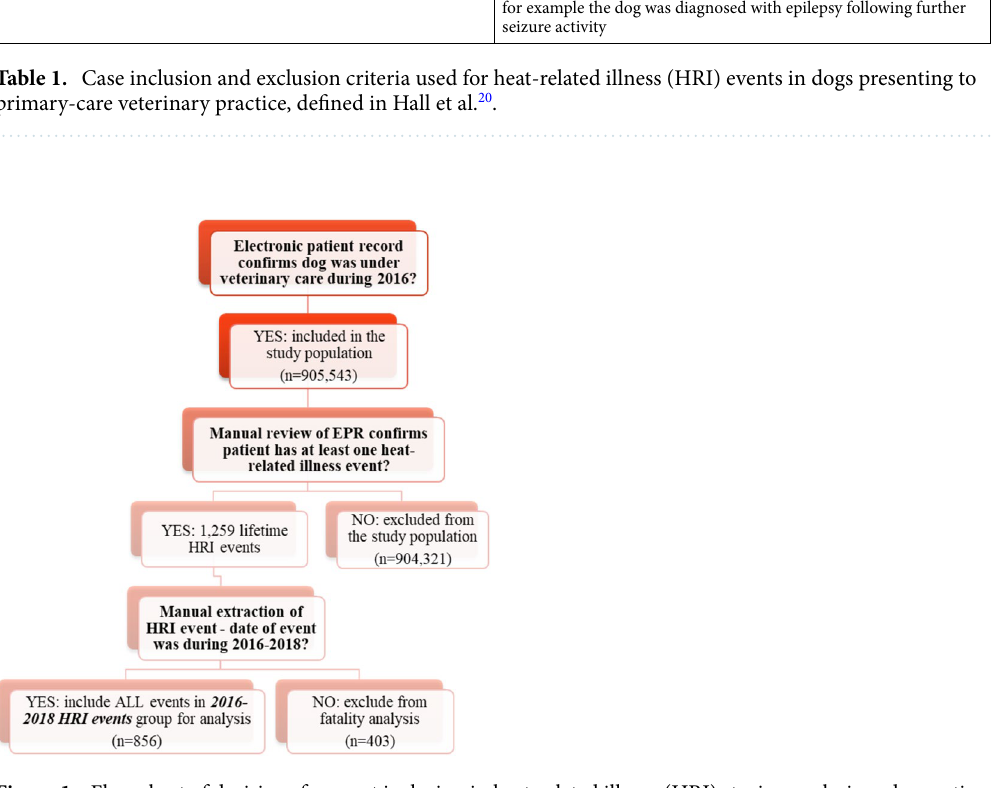
Figure 1. Flow chart of decisions for event inclusion in heat-related illness (HRI) staging analysis and reporting clinical presentations of HRI in UK